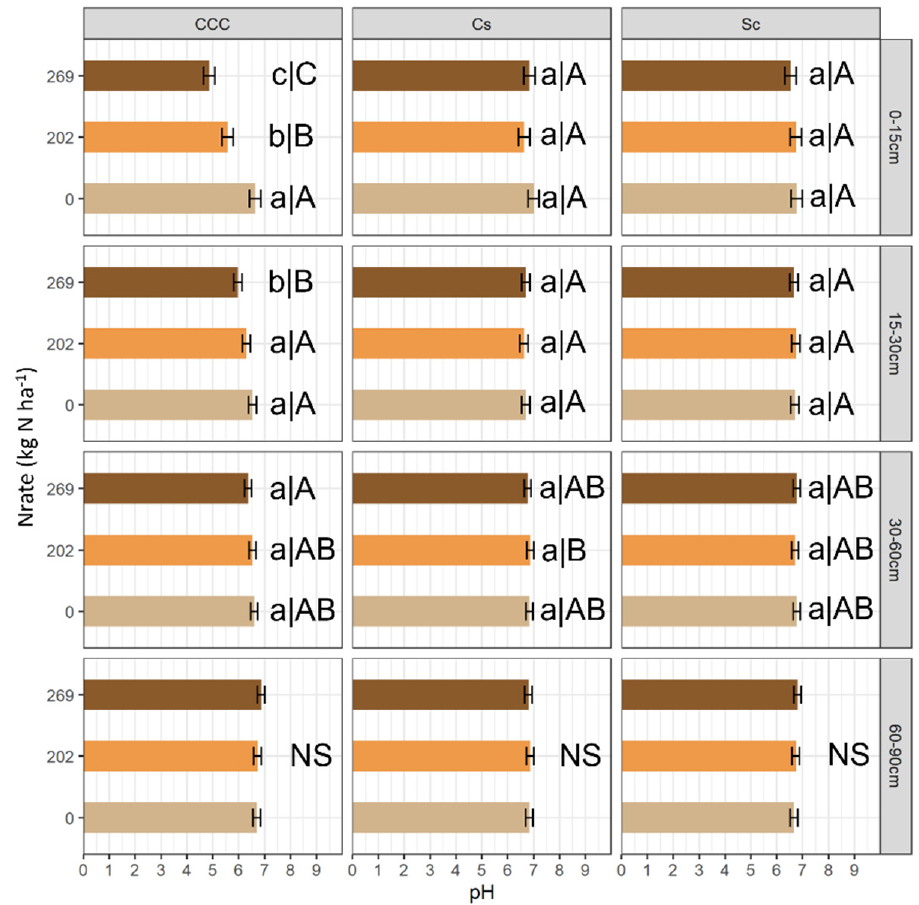
Figure 3. Mean soil pH under each crop rotation (panel columns), N fertilization rate ( Y -axis), and depth (panel rows). Bars show the mean values and the error bars represent the standard error of the treatment means. Crop rotations are continuous corn (CCC), and the corn-soybean rotation (CS) as corn Cs and soybean (Sc) phase, respectively. The N fertilization rates were 0, 202, and 269 (kg N ha − 1 ). For a given depth and within each rotation, mean pH values for each N rate followed by the same lowercase letter are not statistically different ( α = 0.05). Within each depth and across rotations, mean pH values followed by the same uppercase letter are not statistically different ( α = 0.05). Lack of statistically significant differences among treatment means within a given depth is indicated by